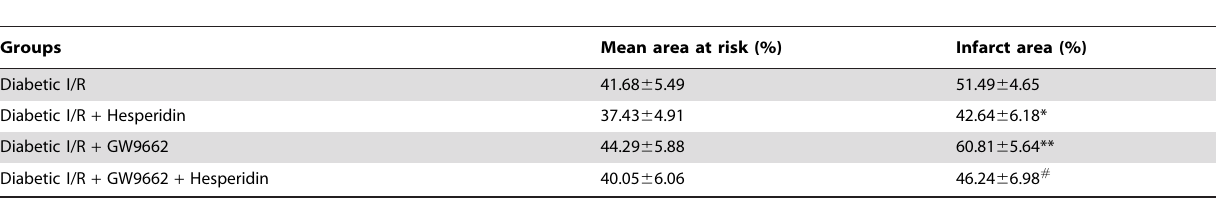
Table 2. Mean area at risk and infarct area in rats in the different experimental groups.